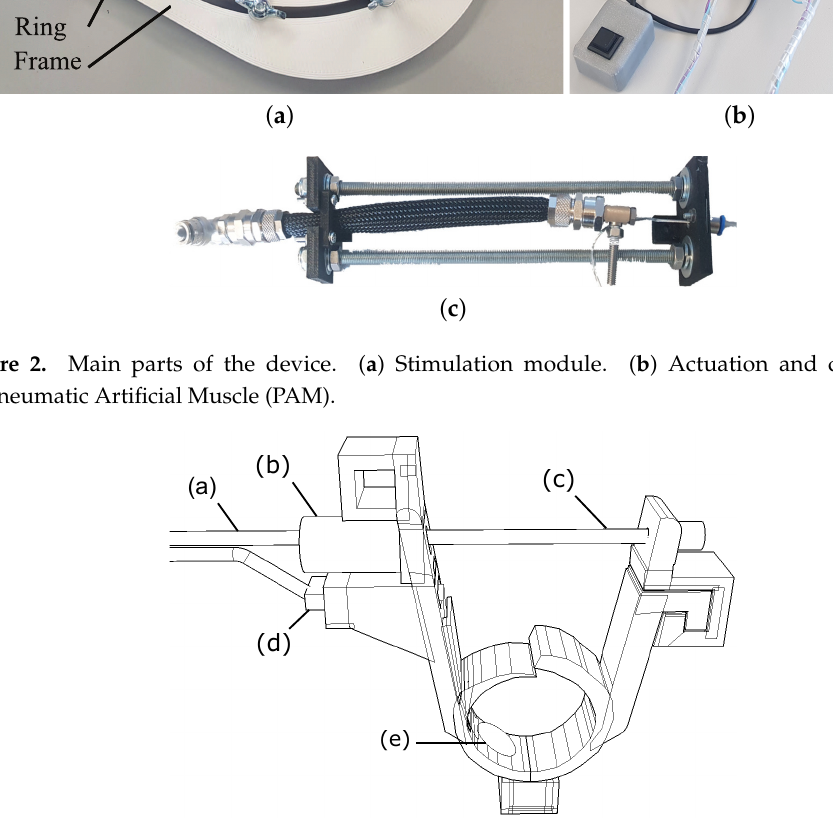
Figure 3. Stimulation ring. ( a ) Bowden cable. ( b ) Frame attach of the Bowden cable. ( c ) Pull rod. ( d ) Electric connector of the force sensor. ( e ) Force sensor IEE